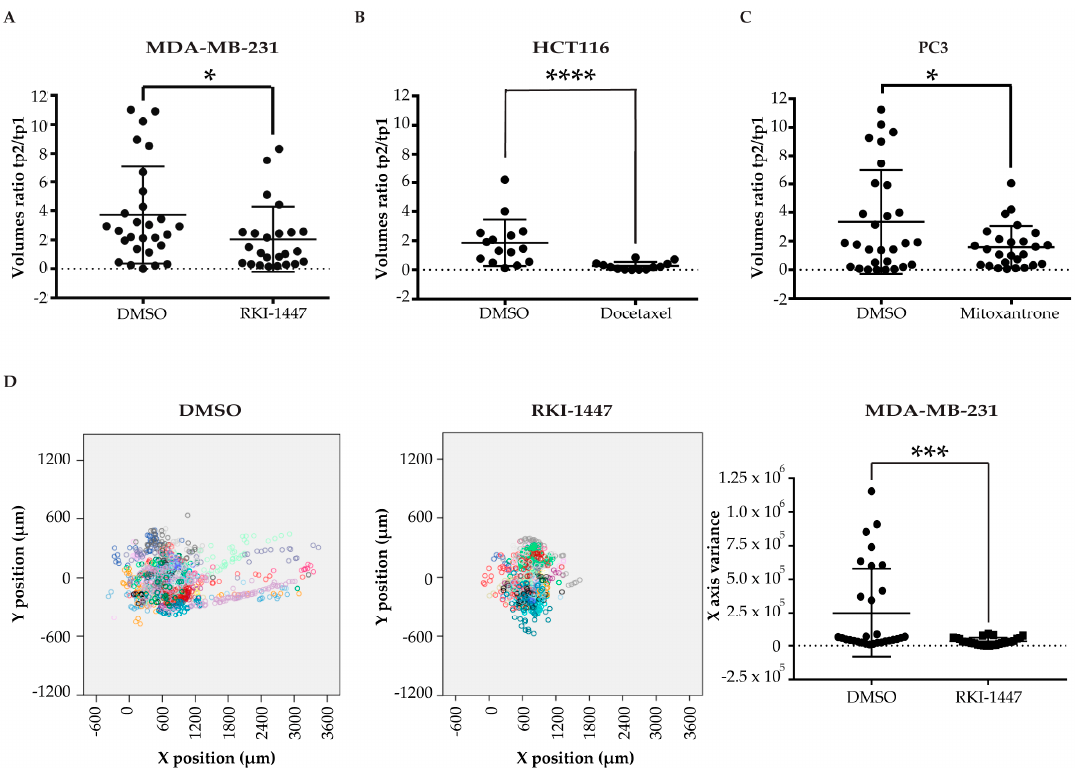
Figure 4. Pharmacological validation ( A–C ) scatter plots of the ratios between the tumor volumes at tp2 and tp1 of MDA-MB-231 ( A ), HCT116 ( B ), and PC3 ( C ) injected cells treated with RKI-1447, docetaxel, and mitoxantrone, respectively, vs. DMSO control. Tp1 refers to 2 hpi for MDA-MB-231 and 24 hpi for HCT116 and PC3. Tp2 corresponds to 96 hpi for MDA-MB-231 and PC3 and 144 hpi for HCT116; ( D ) combined scatter plots, on the left, and scatter dot plot, on the right, of the variance in the x -axis at tp2 of secondary tumor foci in MDA-MB-231 injected larvae, treated with control DMSO and RKI-1447. Each dot or square in the graphs represents the measurement of a fish. * indicates p < 0.05, ** means p < 0.01, 3 *** signify p < 0.001, and **** stays for p < 0.0001. No statistical significance is indicated by ns.